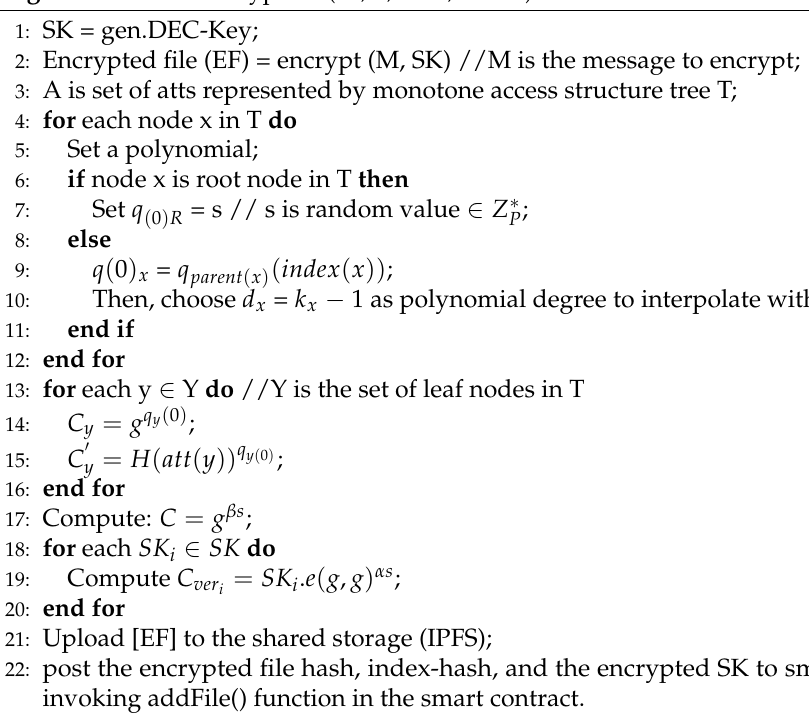
Algorithm 4 Data encryption ( M , T, SPK , FFPK